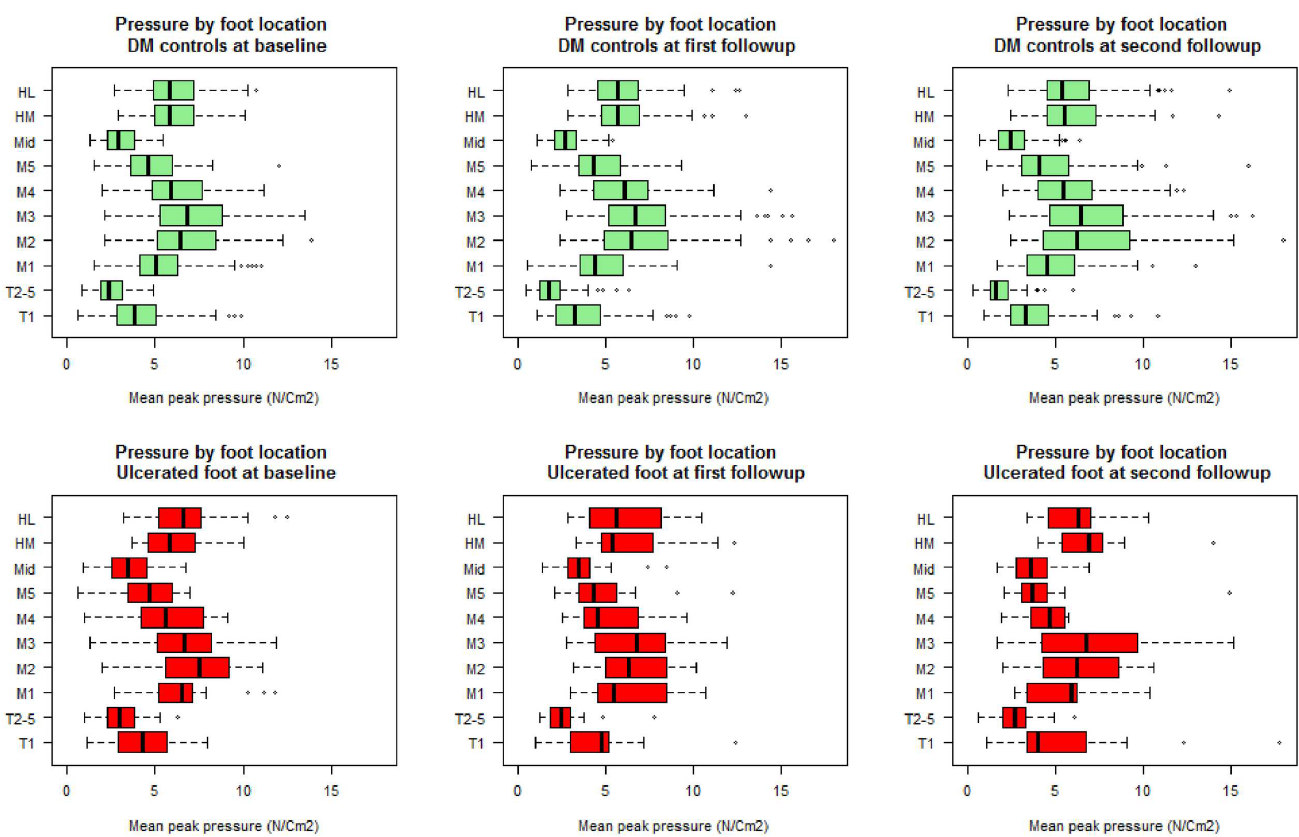
Fig 1. Site-specific mean peak pressuresover time in participants with DFUs and participants without DFUs. Figure indicatesthe mean peak pressure at ten plantar sites in cases (red) and diabetescontrols (DM controls) (green) at each visit. The x-axis has beenscaled to allow for better data visualisation. All values are in N/Cm 2 and are reportedfor 10 plantar foot sites. T1 = hallux (big-toe), T2-5 = toes two to five, M1 = metatarsal one, M2 = metatarsal two, M3 = metatarsal three, M4 = metatarsal four, M5 = metatarsal five, Mid = mid-foot, HM = medial heel and HL = lateral heel.